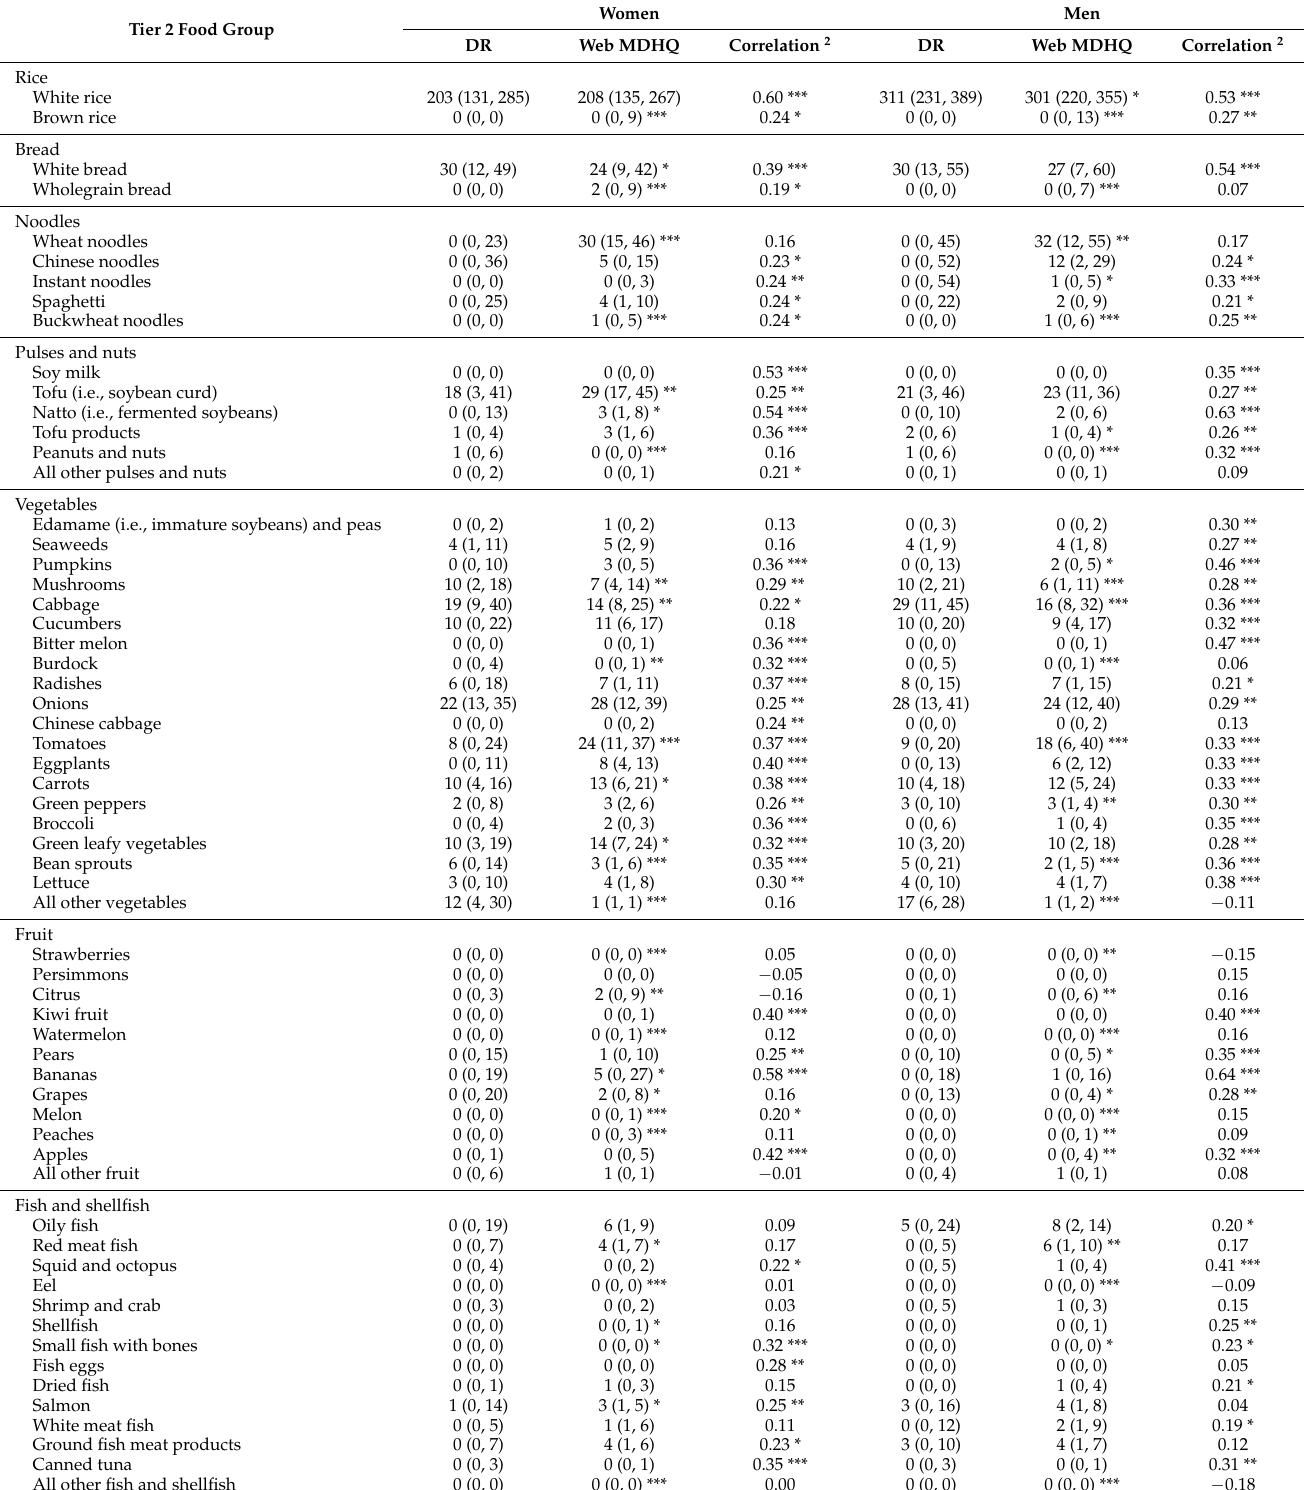
Table 5. Median estimates of overall intakes of Tier 2 food groups (in grams per day) derived from the 4-day weighed dietary record (DR) and those derived from the web version of the Meal-based Diet History Questionnaire (MDHQ) and Spearman’s correlation coefficients between estimates derived from the DR and the web version of MDHQ in 111 Japanese women and 111 Japanese men 1